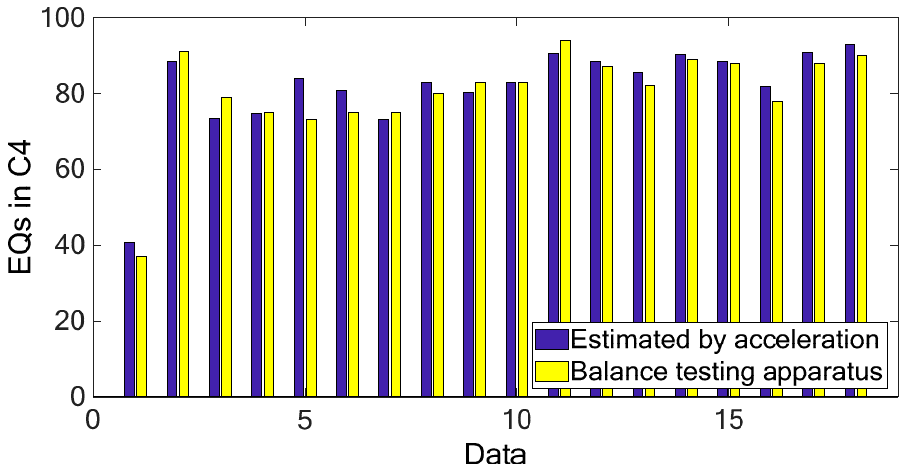
Figure 16. Estimated EQs values compared with EQs values of commercial computer-aid balance testing apparatus in C3.